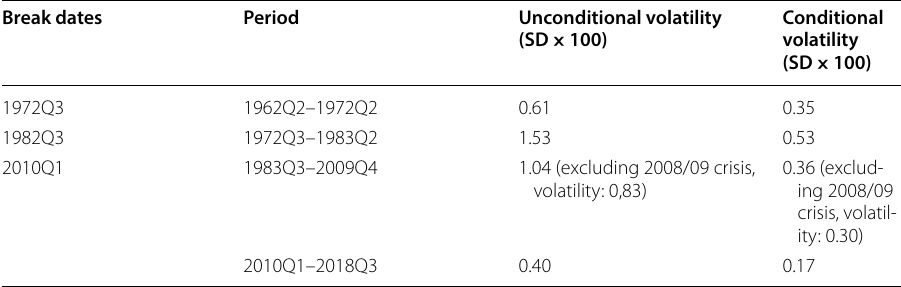
Error terms are calculated on the basis of AR(8) process